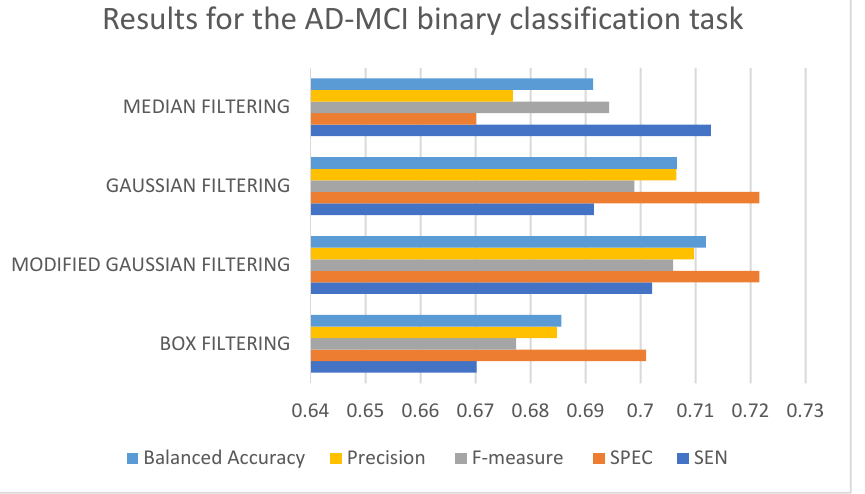
Figure 5. Results of different 3D-CNN architectures for the AD-MCI binary classification task.